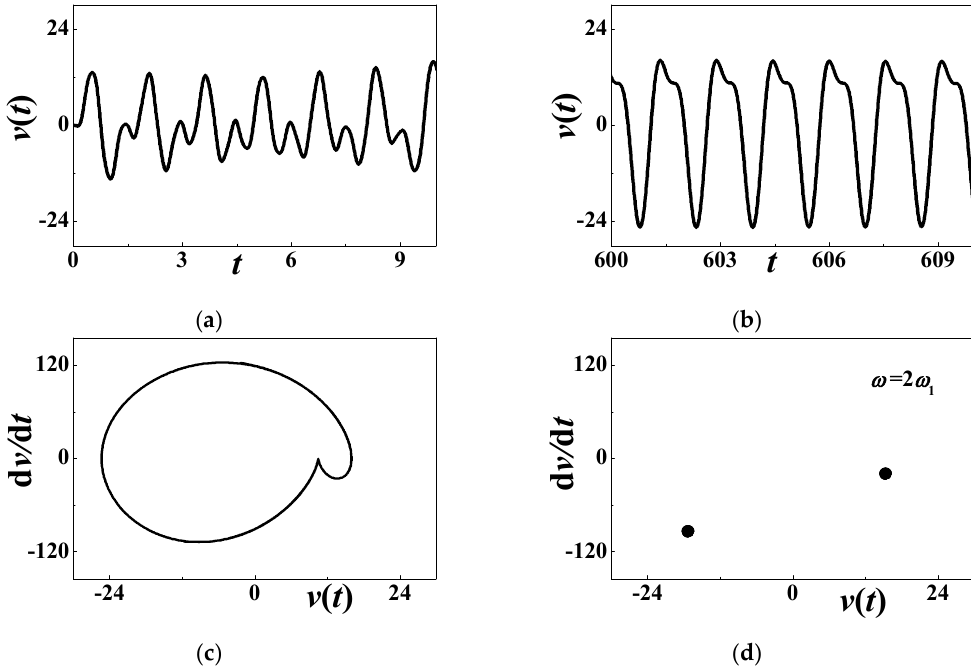
Figure 8. The periodic response when ω = 8: ( a ) initial history; ( b ) steady-state response; ( c ) phase diagram; ( d ) Poincare map. The solid blue dots stand for analytical prediction and others for numerical simulation.